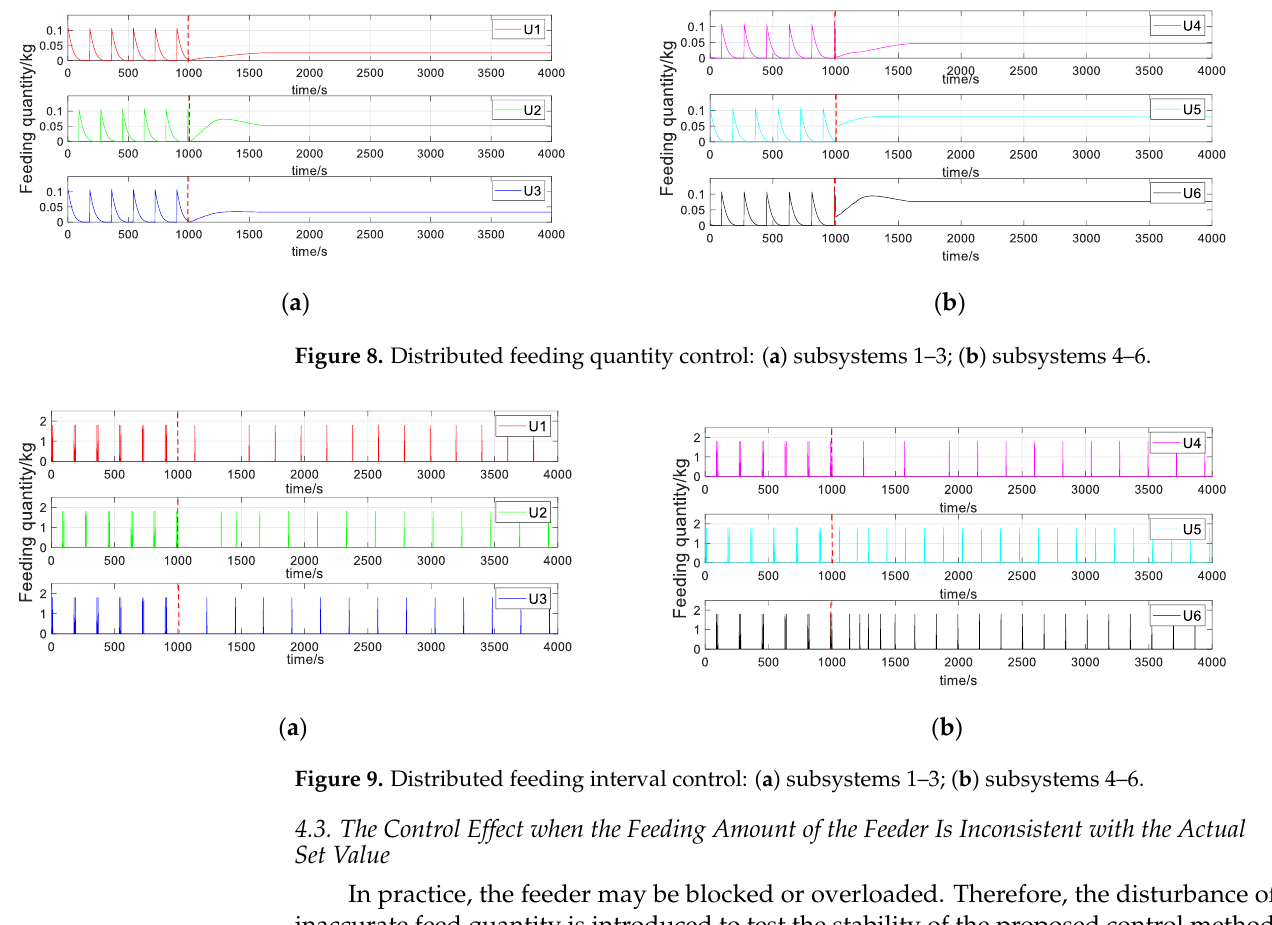
( b ) Figure 7. Variation of alumina concentration: ( a ) subsystems 1 – 3; and ( b ) subsystems 4 – 6. In the first 1000 s of Figure 7, the concentration of the six subsystems is distributed very unevenly, although it is roughly in the appropriate range after feeding for a period using the traditional control strategy. After 1000 s, the distributed subspace predictive control method proposed in this paper is used to control the aluminum reduction cell. Each feeder is distributed as needed under the influence of other feeders, so that the var- iation of the alumina concentration is greatly reduced in space and time, and the concen- tration of the six areas is well controlled near the set value, the alumina concentration distribution in the entire cell is more uniform. The continuous feeding amount of each feeder in Figure 8. Since alumina is dumped in discrete 1.8 kg batches each time during the actual operation on site, the actual feeding interval is calculated according to the